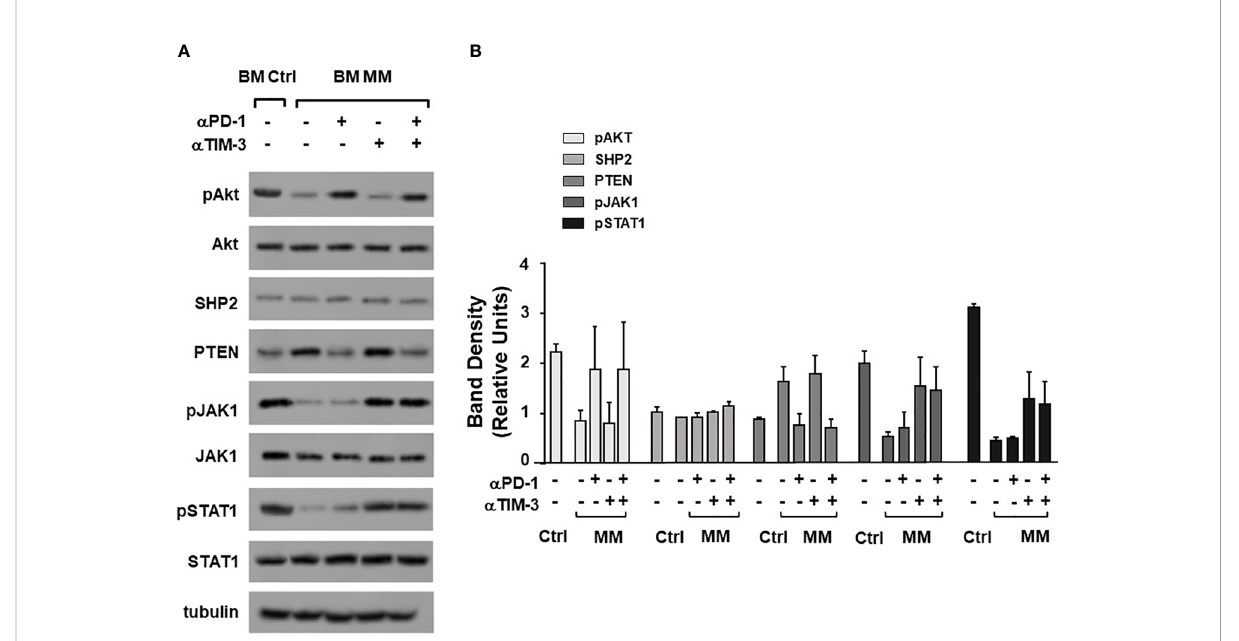
FIGURE 5 Alterations of TCR-associated molecules are mitigated by a PD-1 and/or a TIM-3. (A) Western blot analysis of pAKT, AKT, SHP2, PTEN, pJAK-1, JAK-1, pSTAT-1, and STAT-1 expression in BM Ctrl and BM MM gd T cells from one representative experiment after ZA stimulation in the absence or in the presence of a PD1, a TIM-3, and the combination thereof. Tubulin expression is shown to con fi rm equal protein loading per lane. (B) Densitometric analysis of pooled data. Bars represent mean values ± SE of 2